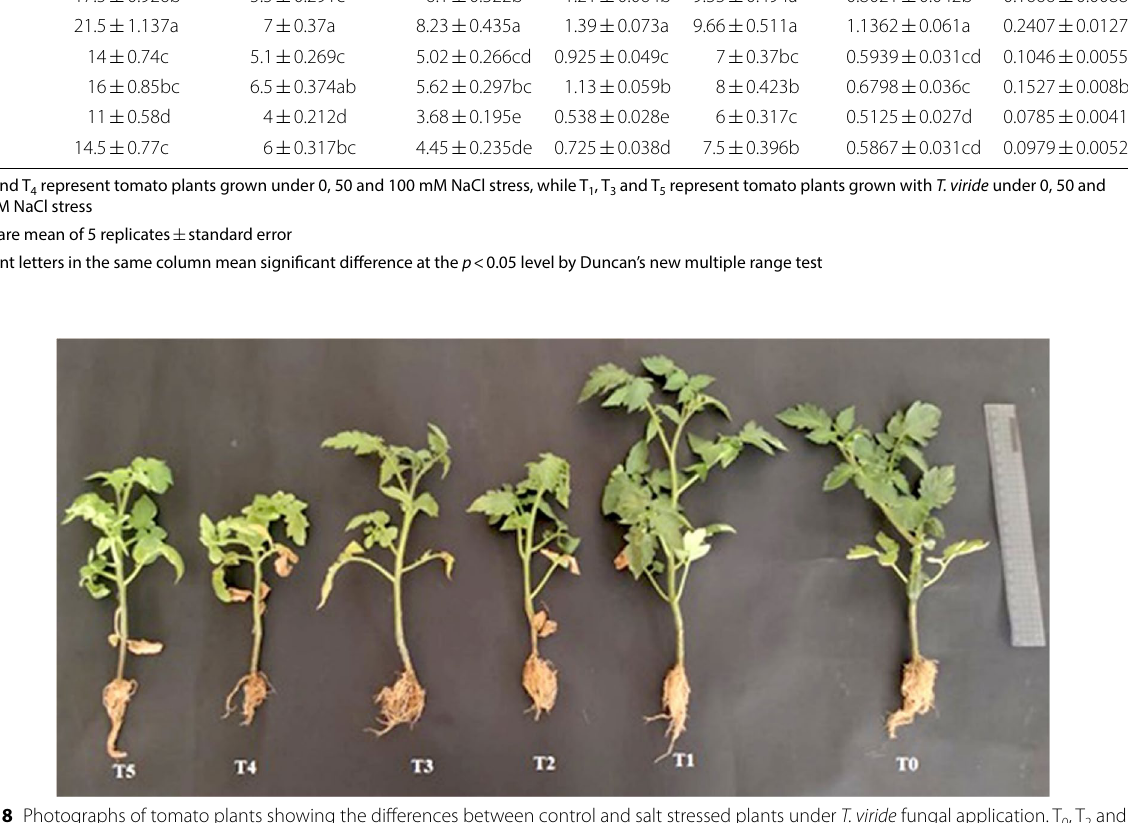
Table 5 Effects of NaCl stress and T. viride on morphological traits of tomato plants under greenhouse conditions Treatments Shoot height (cm) Root length (cm) Shoot FW (g)